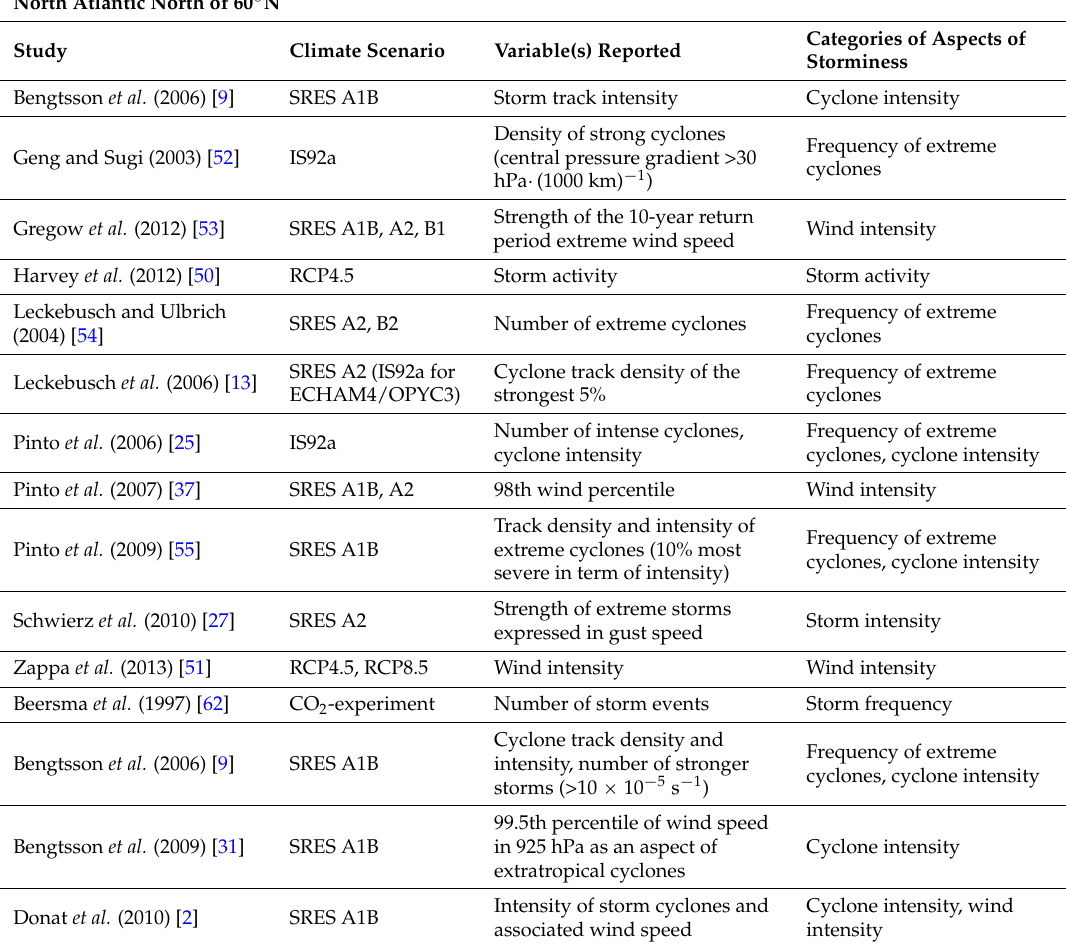
Table B1. Climate scenarios, variables reported in the reviewed studies and their assignment to the assessed categories frequency, intensity and activity for the subregions evaluated in this review. The listed studies are sorted according to the surname of the lead